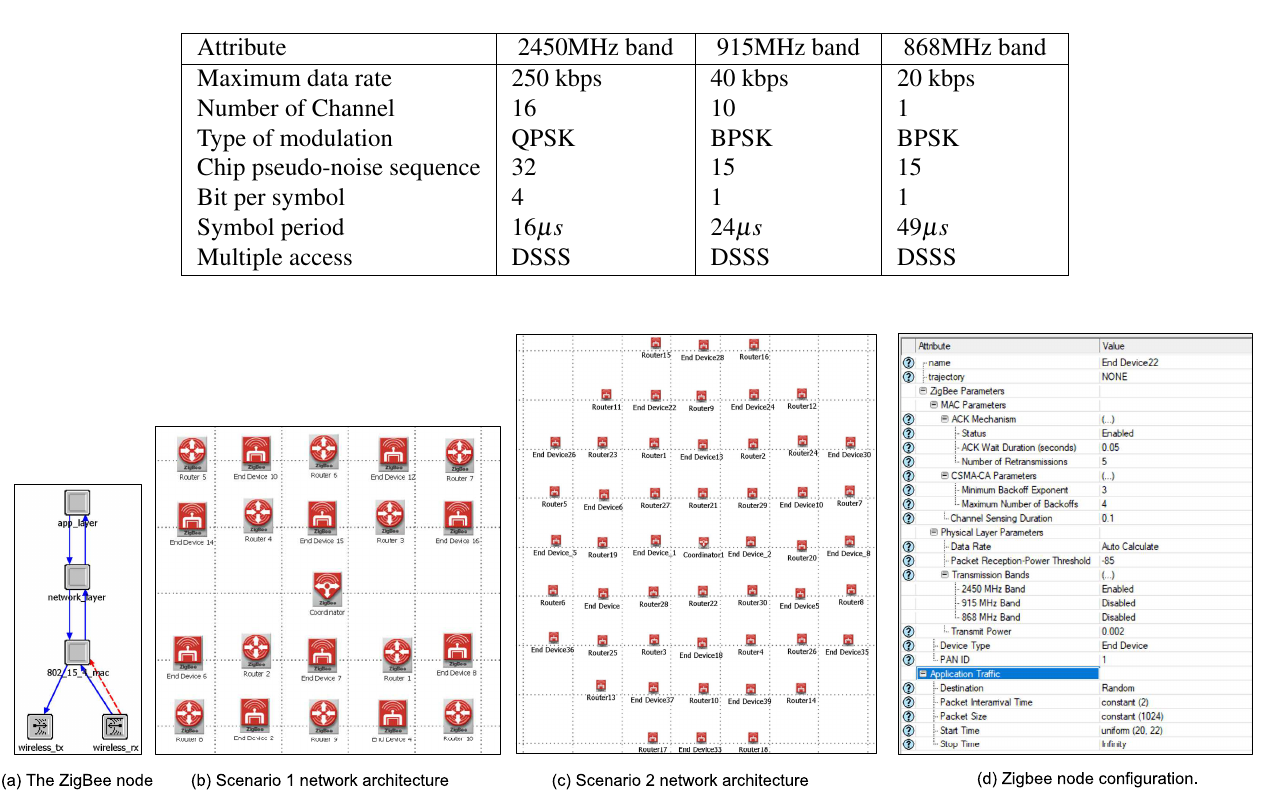
Table 1. ZigBee physical layer specifications.